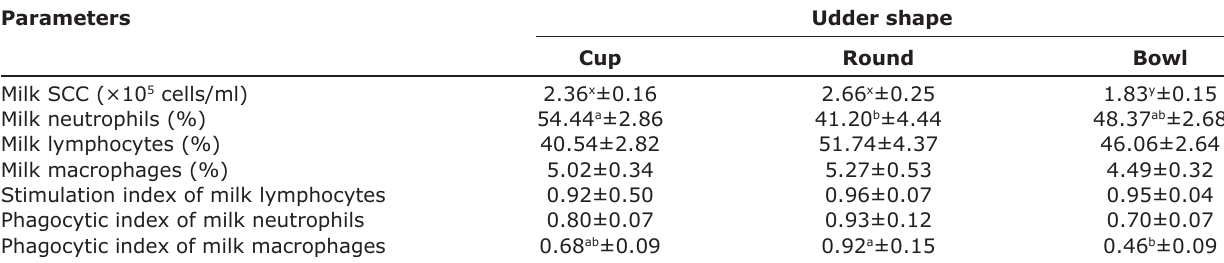
Table-3: Effect of udder shape on milk SCC, milk DLC and in vitro activity of milk leukocytes in high yielding crossbred cows. Parameters